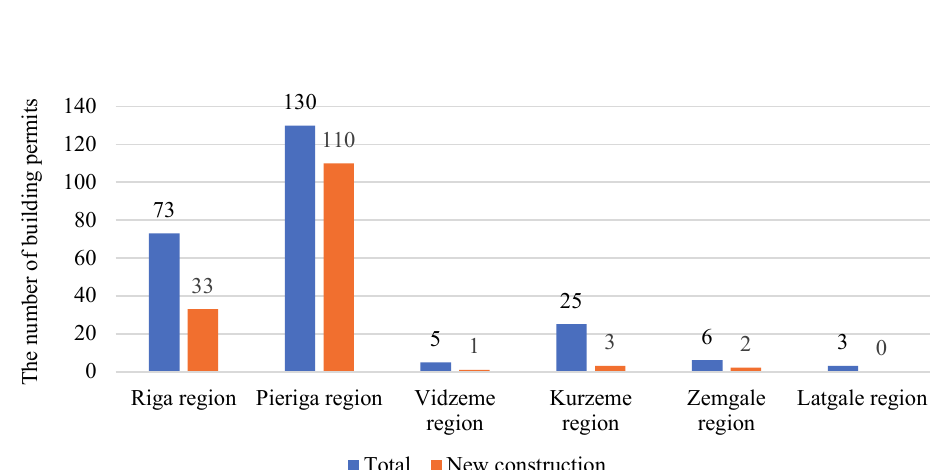
Fig. 8. The number of building permits granted in statistical regions and cities under state jurisdiction by quarter; two- and more dwelling buildings in the period of 2020Q4 – 2021Q3 (developed by the authors based on European Statistics Database Eurostat).